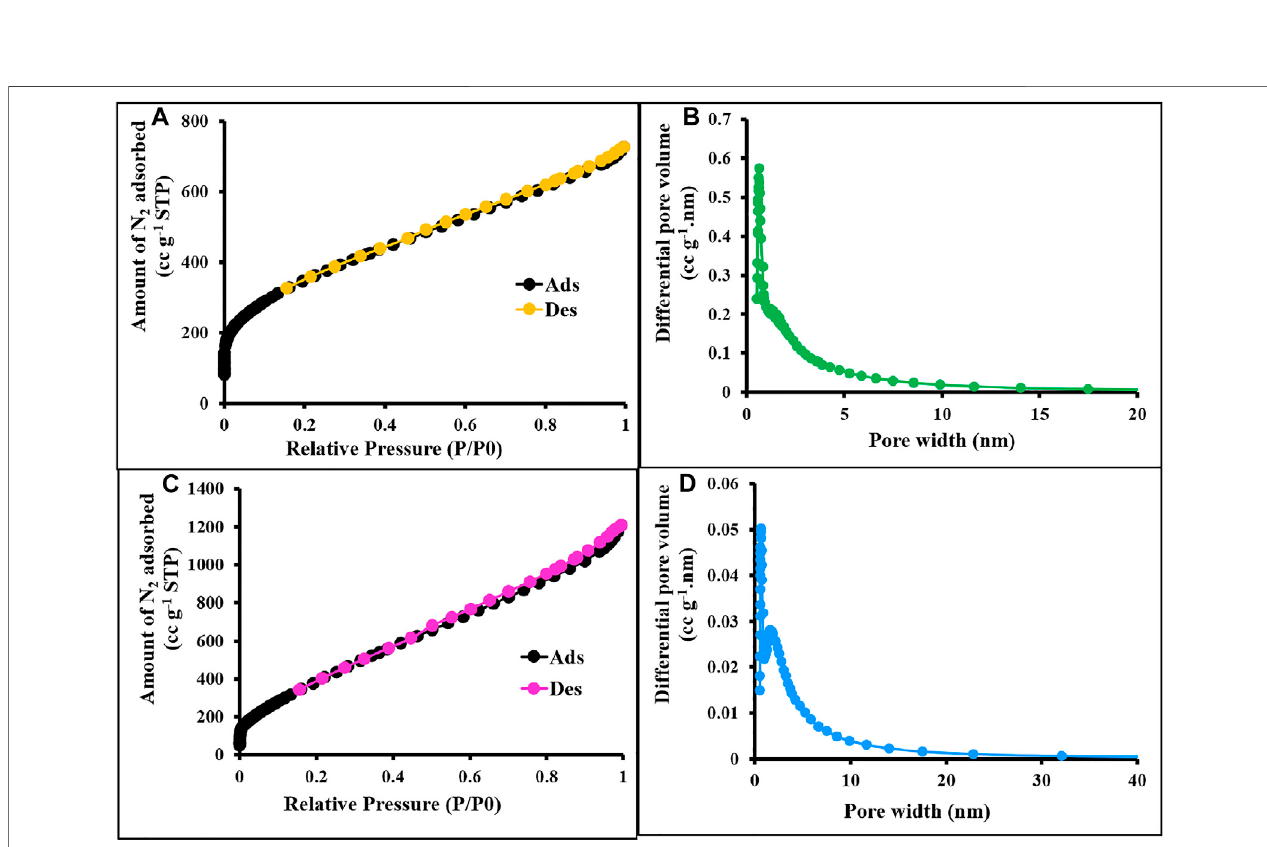
FIGURE 3 | N 2 sorption – desorption isotherms and PSD of c-2CzPN – KOH (A,B) and c-4CzPN – KOH (C,D) at 77 K.